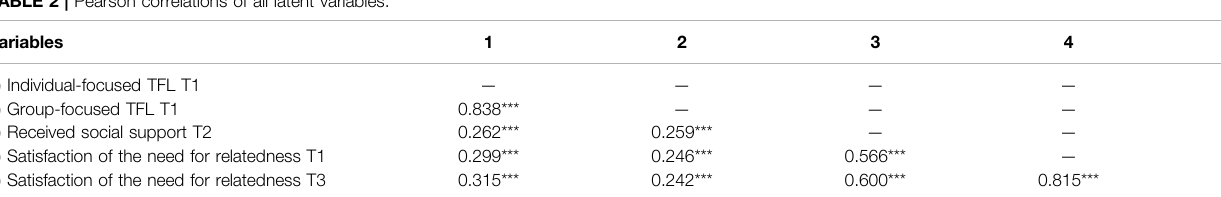
TABLE 2 | Pearson correlations of all latent variables.